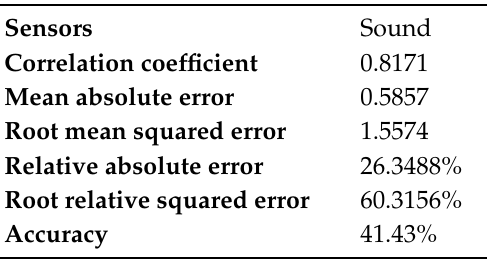
Table 8. Recognition of environments using the IBk method implemented with Weka software.